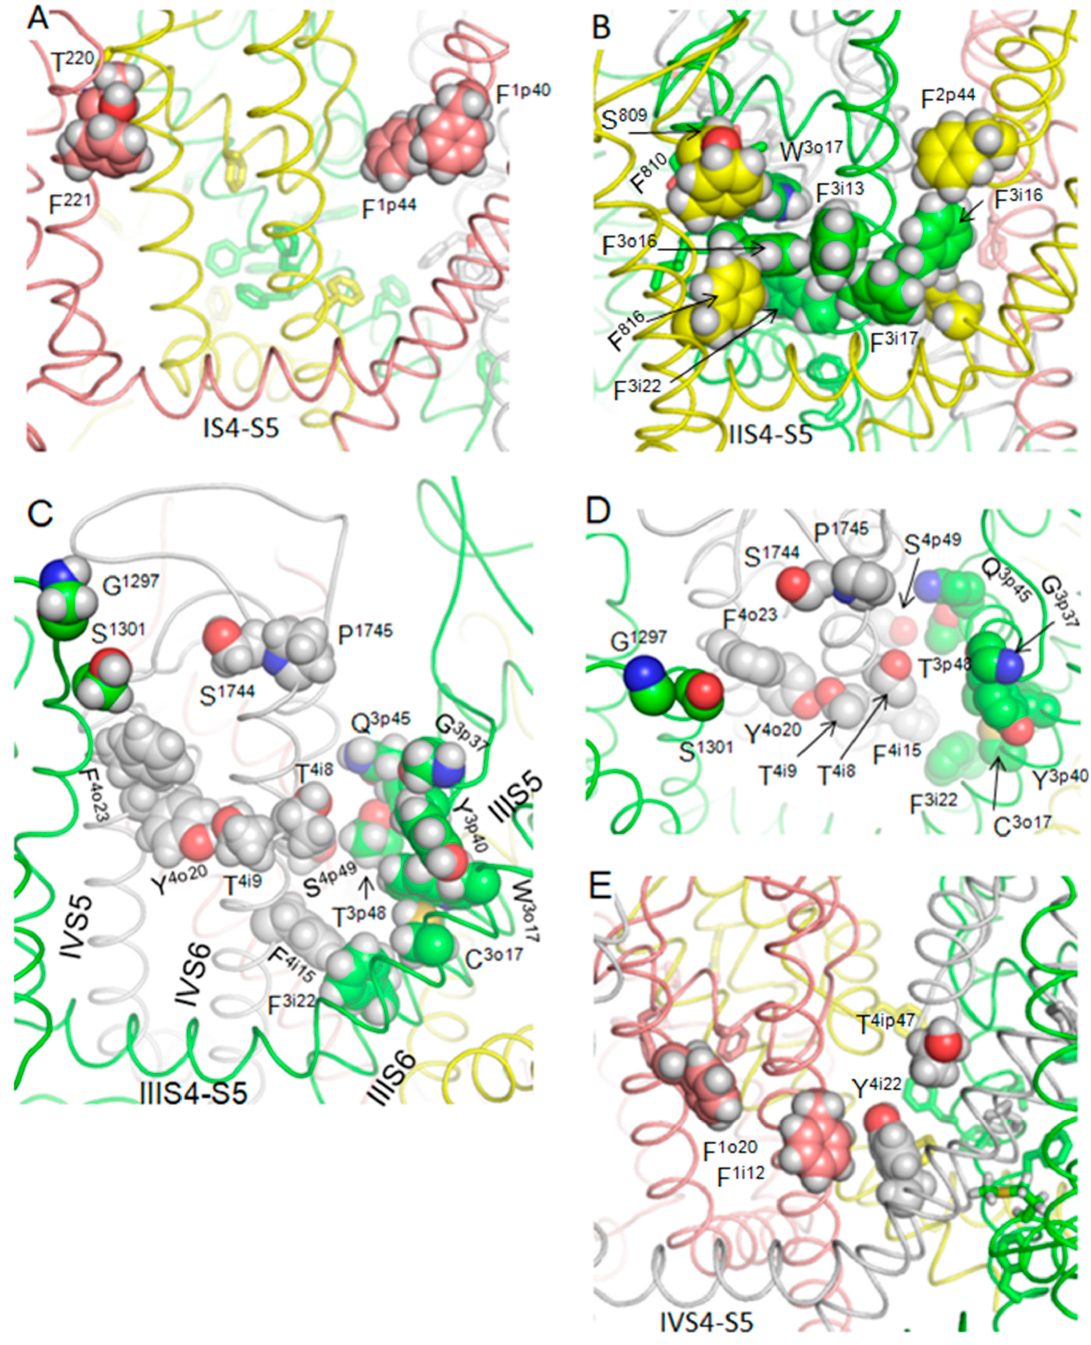
Figure 5. Intra-membrane views at four sides of Nav1.5. ( A ) Interface I/II. ( B ) Interface II/III. ( C ) Interface III/IV. ( D ) Extracellular view of interface III/IV. ( E ) Interface IV/I. Space-filled are lipid-facing polar and aromatic residues, which could attract the ammonium group of MEX in the hydrophobic path from the extracellular space to the pore. Side III/IV has the largest number of polar residues, which may attract polar groups of lipids. MEX could move through the interface between the III/IV side and lipids into the closed-channel